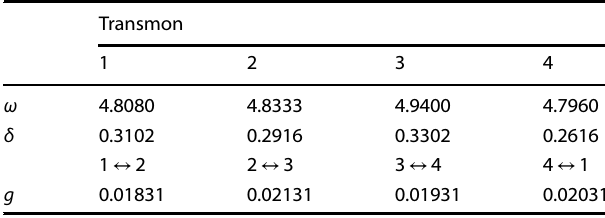
Table 2. Device parameters appearing in Eq. (6) for a four-transmon